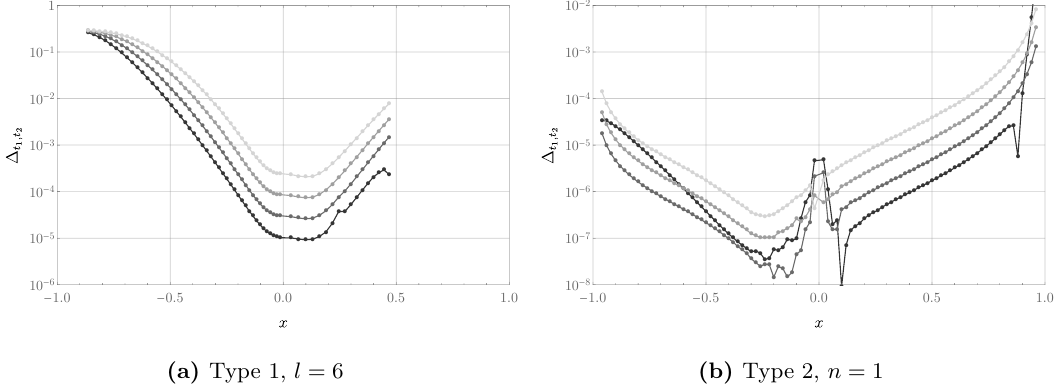
Figure 8 . Example behavior of ∆ t for the Dirac fermion (the behavior for the scalar is very 1 ,t 2 similar). (a) shows the Type 1 deformation (2.5) with l = 6 , while (b) shows the Type 2 defor- mation (2.7) with n = 1 . For both we use a grid size of N = 800 and t 1 and t 2 are adjacent elements from the set { 0 . 000125 , 0 . 00025 , 0 . 0005 , 0 . 001 , 0 . 002 } with t 2 < t 1 ; from light gray to black the curves correspond to decreasing t 1 , t 2 .